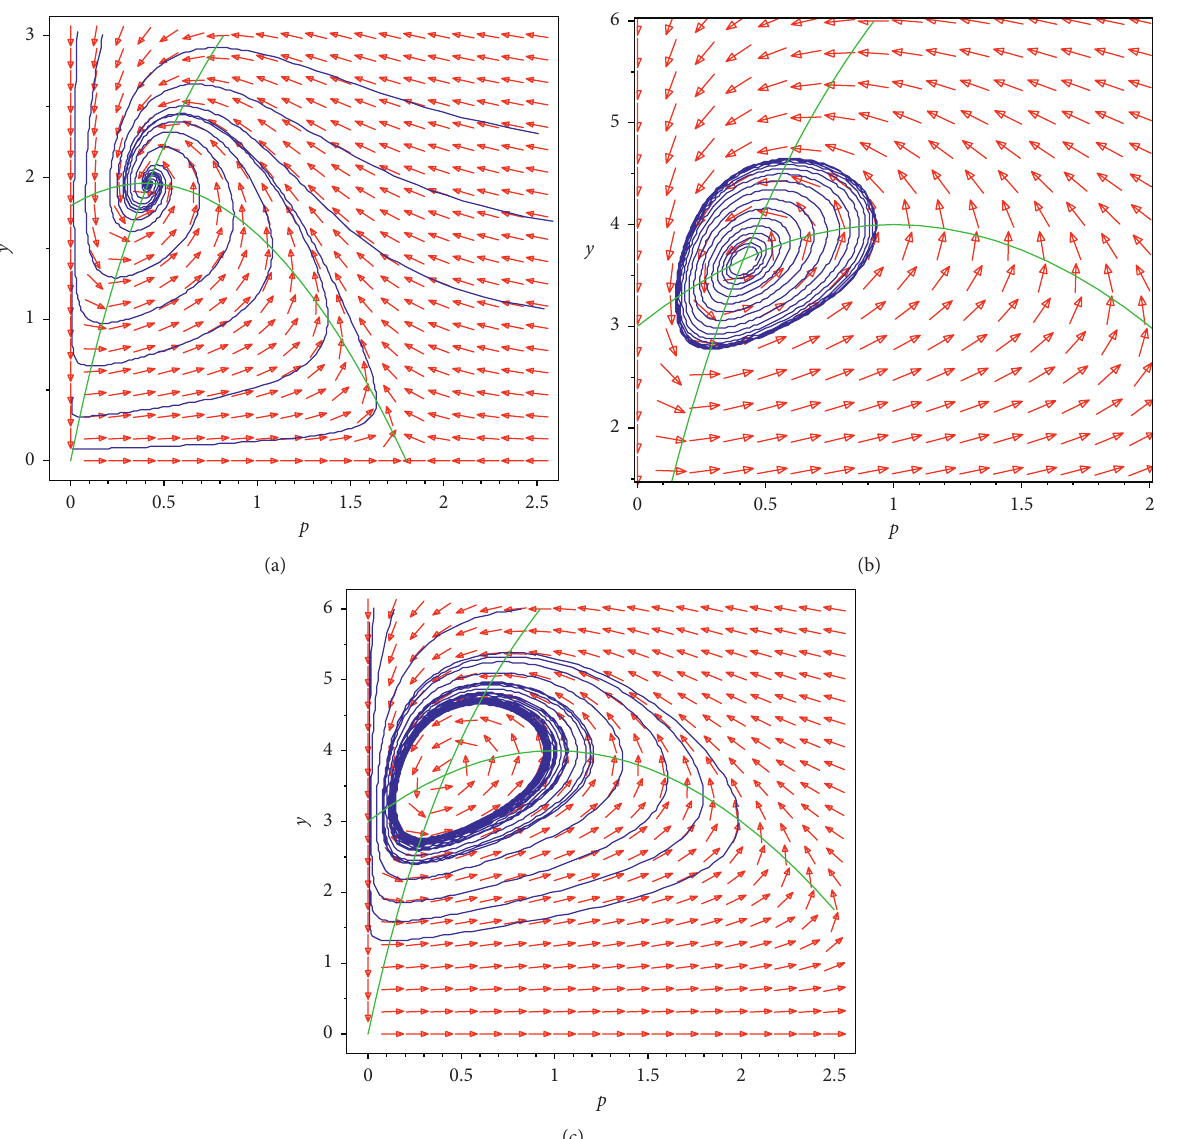
Figure 1: (a) Phase diagram of system (7) with k � 1 . 8and a � 0 . 15. (b) The existence of the limit cycle with k � 3and a � 0 . 08. (c) Stability of the limit